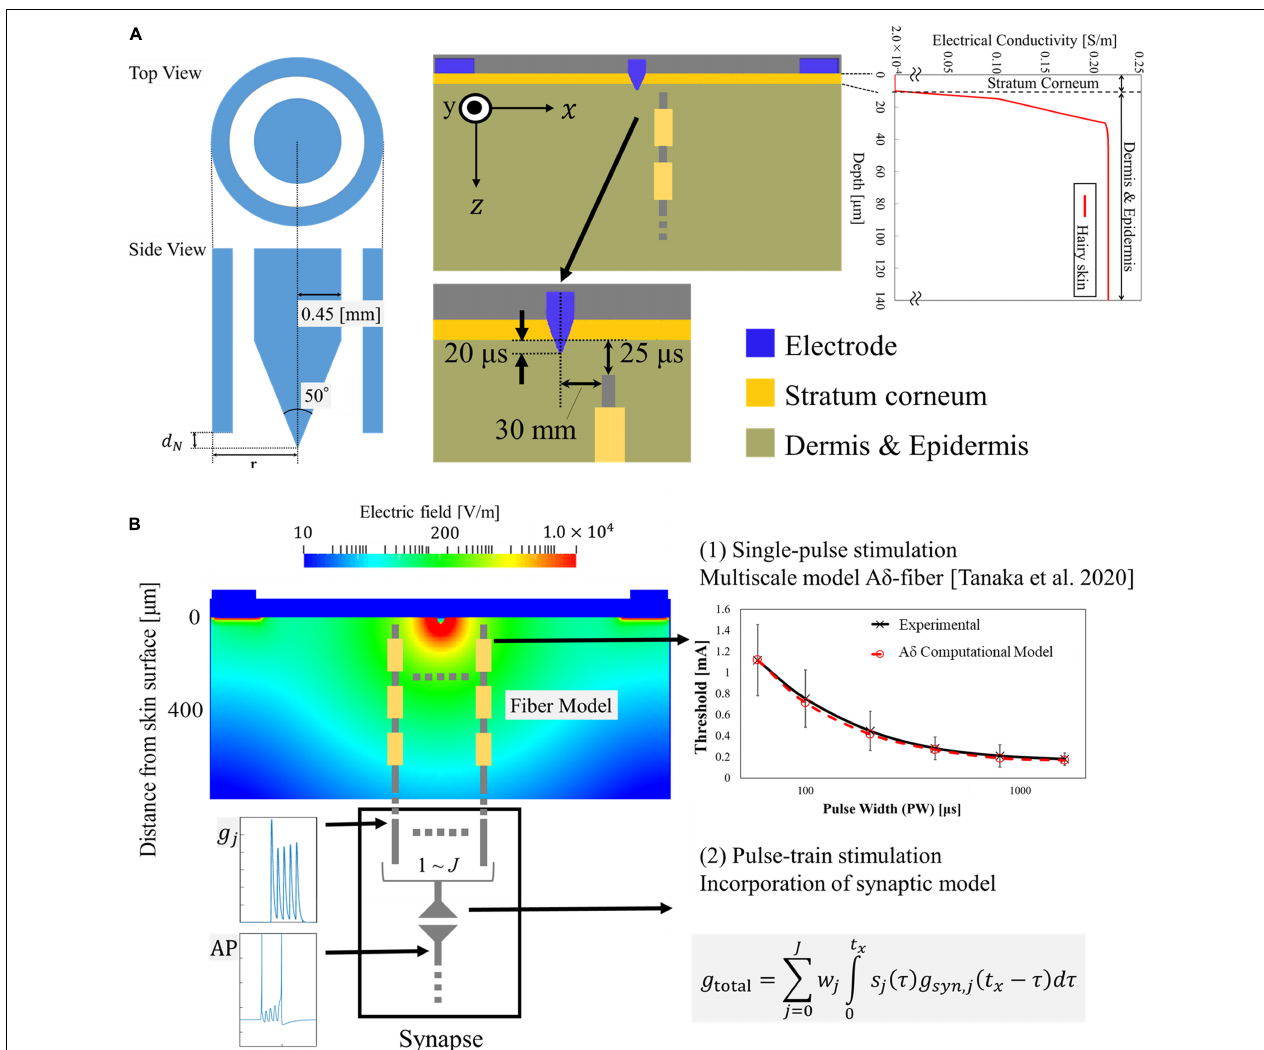
FIGURE 2 | Multiscale electrical stimulation model with synaptic effect: (A) Layered skin model with A δ -fiber and IES electrode model. Profile of electrical conductivity estimated from the water content of the tissue. (B) The electric field distribution on the transversal plane of the skin model is illustrated, as an example, for an injection current of 0.02 mA. The response of the A δ -fiber matched the experimental strength-duration curves for single-pulse stimulation in our previous study (Tanaka et al., 2021). In this work, the afferent spikes of the A δ -fiber originated from the pulse-train are computed and integrated into a synaptic